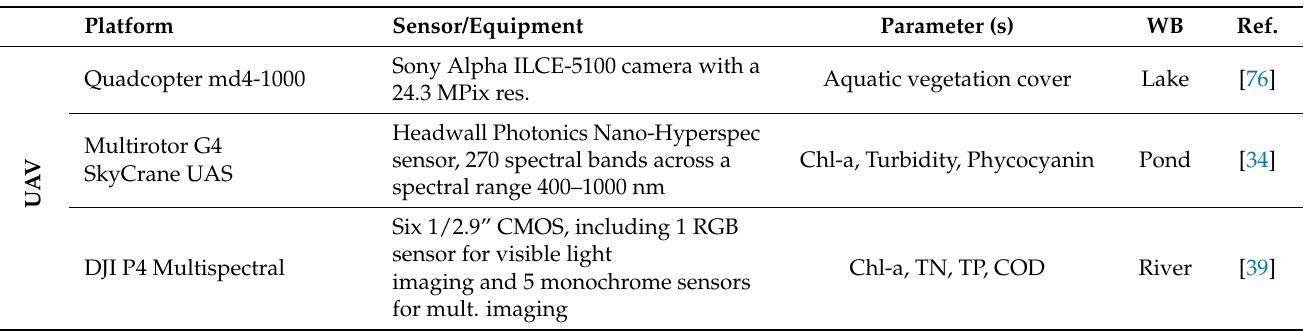
Table 2. The variety of sensors on board Unmanned Aerial Vehicles (UAVs), Unmanned Surface Vehi- cles (USVs) and airborne platforms and their potential to monitor different water quality parameters in various water